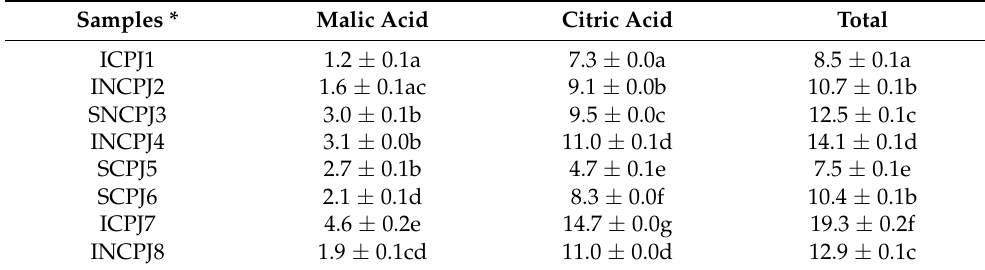
Table 6. Organic acids (g/L) present in PJs.